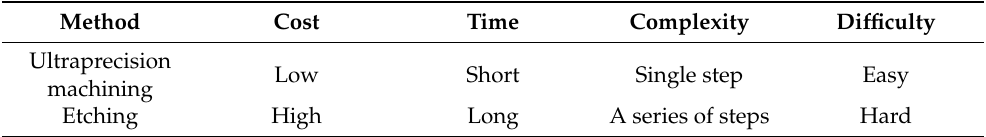
Table 4. The advantages of ultraprecision machining. Method Cost Time Complexity Difficulty Ultraprecision Low Short Single step